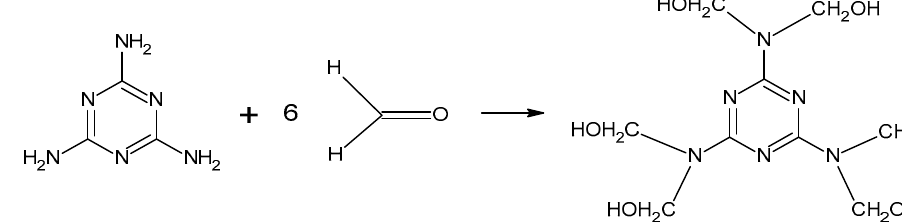
Figure 3. Reaction between melamine and formaldehyde.